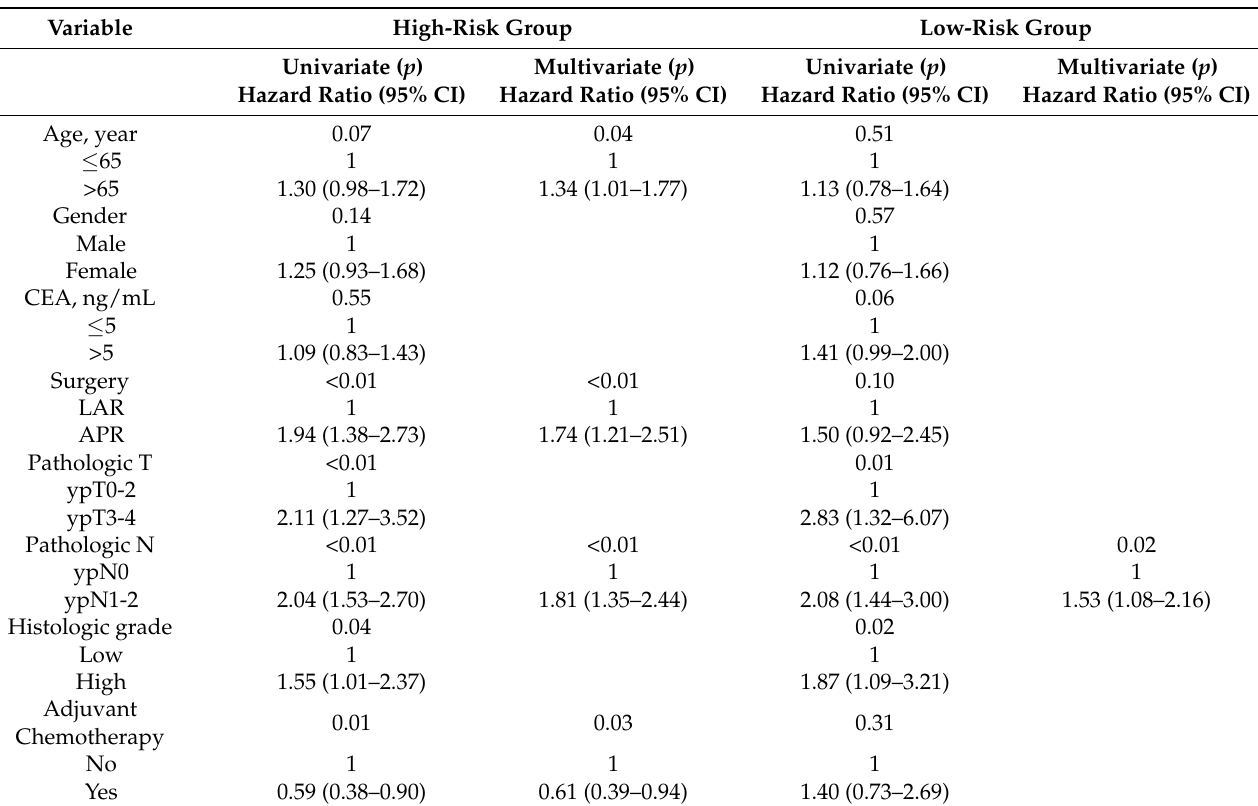
Table 3. Prognostic factors associated with recurrence-free survival in high-risk group and low- risk